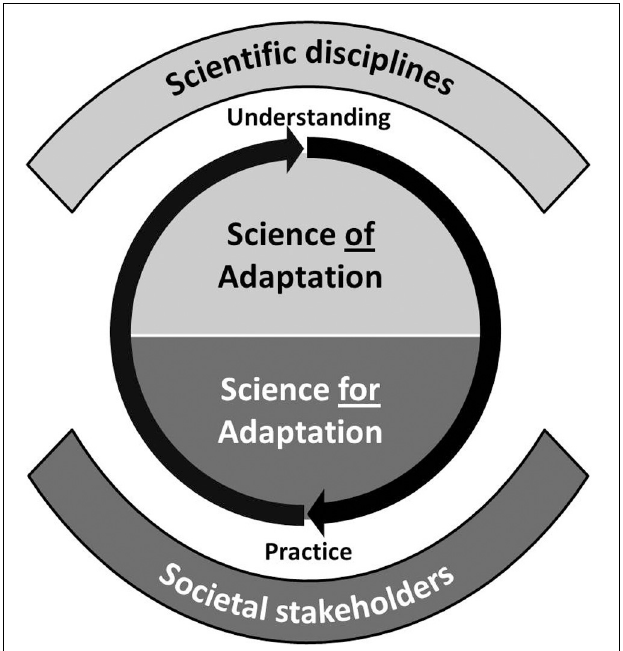
FIGURE 1 | Disentangling “adaptation science” into science of and science for adaptation. Disciplines include but are not limited to political science, economics, psychology, sociology. Stakeholders can be local, regional, national, or international; public or private.